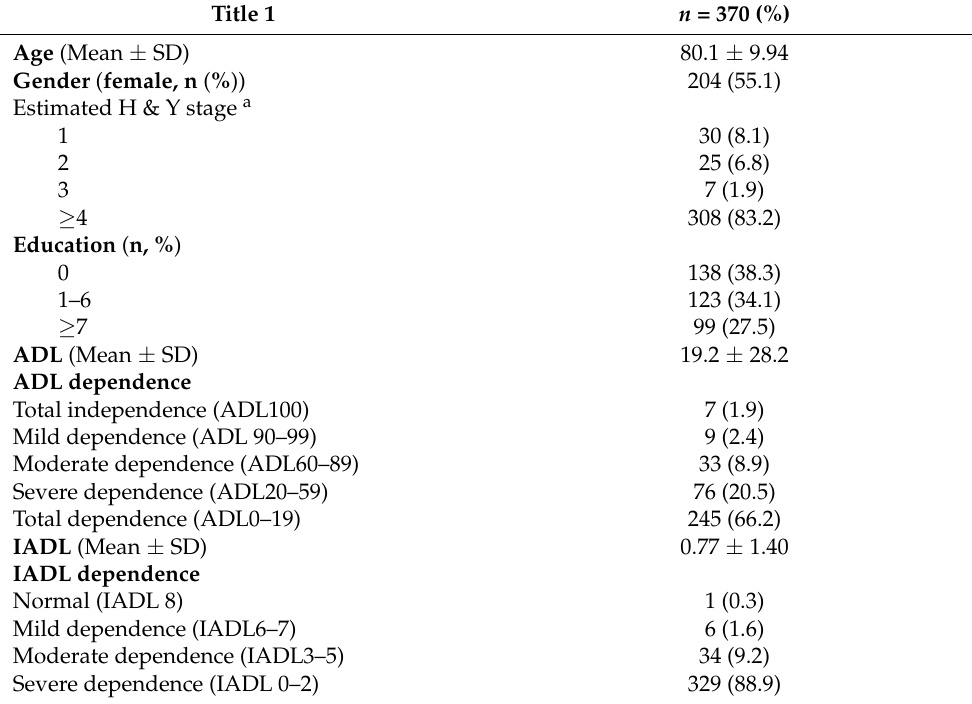
Table 1. Demographic features of the PD patients in nursing